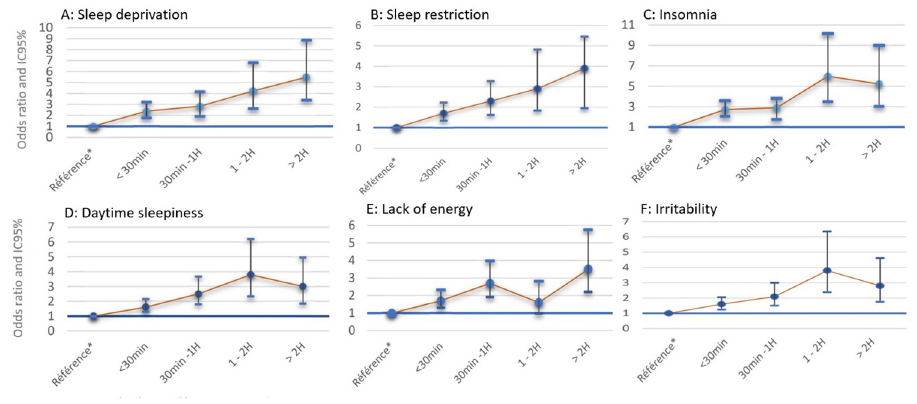
Fig 2. Duration of night time screen time use and